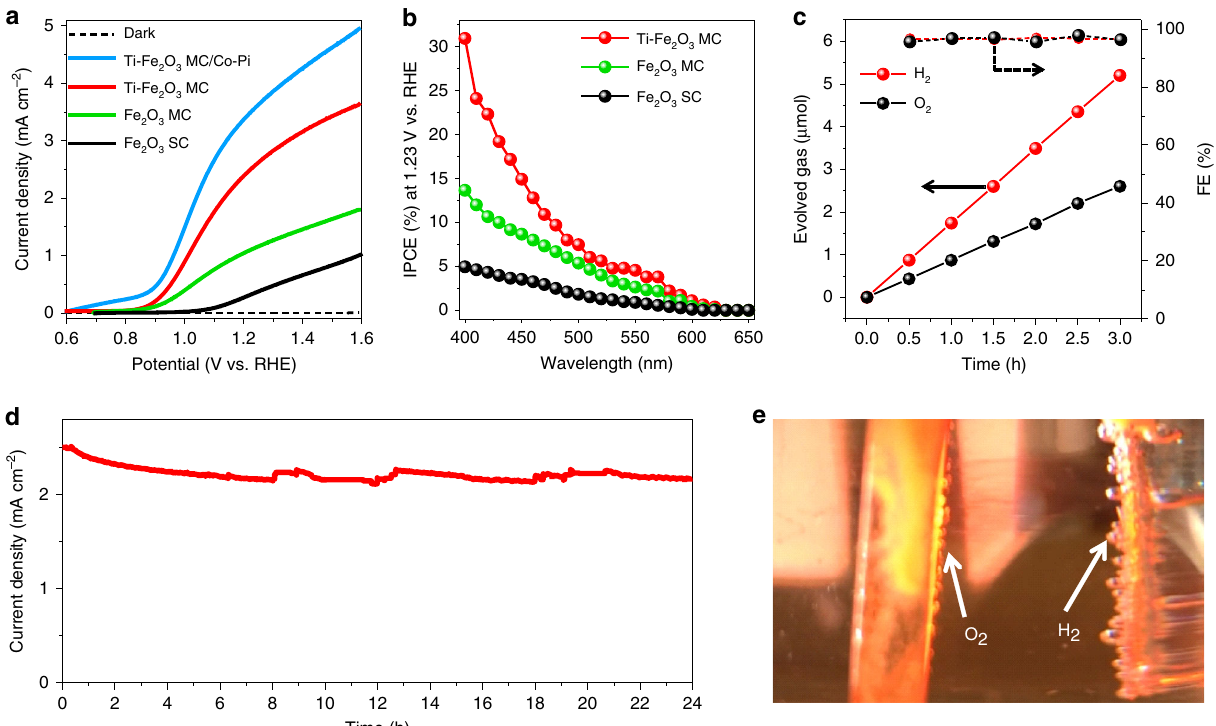
Fig. 3 PEC performance. a Current density – voltage curves of Ti – Fe 2 O 3 MC/Co – Pi, Ti – Fe 2 O 3 MC, Fe 2 O 3 MC, and Fe 2 O 3 SC photoanodes prepared by 50 cycles of spin-coatings measured under back illumination with AM 1.5 G simulated sunlight in 1.0 M NaOH. b IPCE curves measured at 1.23 V vs. RHE for the Ti – Fe 2 O 3 MC, Fe 2 O 3 MC, and Fe 2 O 3 SC photoanodes. c Gas evolved from Ti – Fe 2 O 3 MC photoanode and Pt counter electrode with an applied potential of 1.23 V vs. RHE under back illumination during 3 h and the corresponding Faradaic ef fi ciencies (FEs). d Current density – time curve of the Ti – Fe 2 O 3 MC photoanode measured at 1.23 V vs RHE under back illumination. e Photograph showing gas evolution from Ti – Fe 2 O 3 MC photoanode and Pt counter electrode under an applied potential of 1.23 V vs.